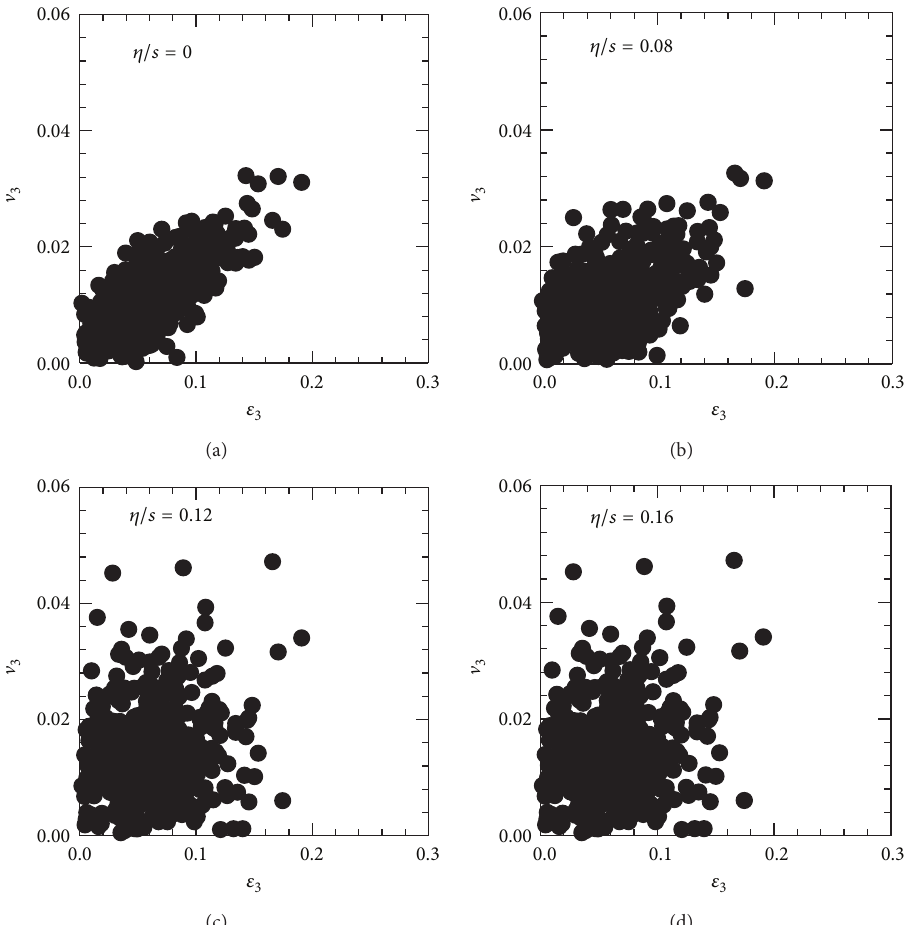
Figure 23: Correlation between triangular flow ( V 3 ) and initial triangularity (𝜖 3 ) is shown for four values of fluid viscosity to entropy ratio 𝜂/𝑠 = 0 , 0.08, 0.12, and 0.16. The figure is from [139].